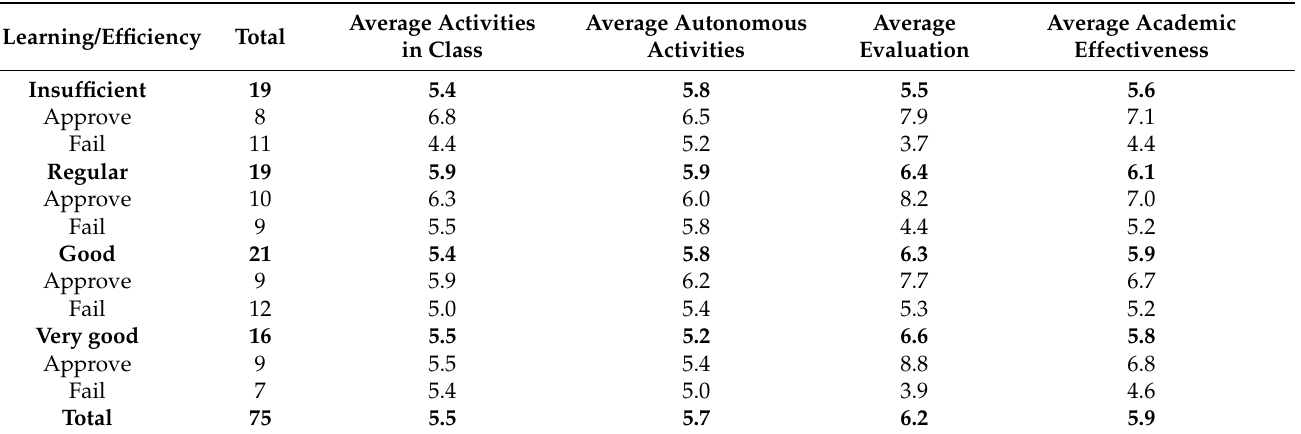
Table 15. Analysis of the data obtained from the 2020 period with the establishment of the categories of learning and academic effectiveness.